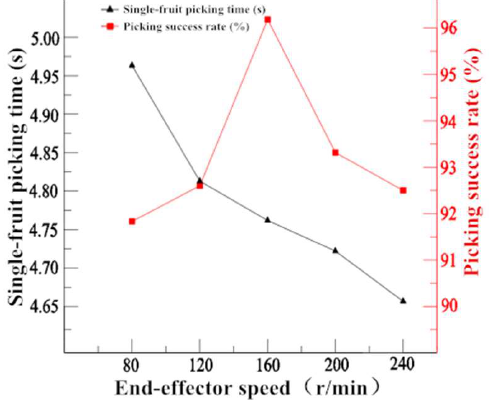
Figure 14. Effect of different end-effector speeds on picking performance.